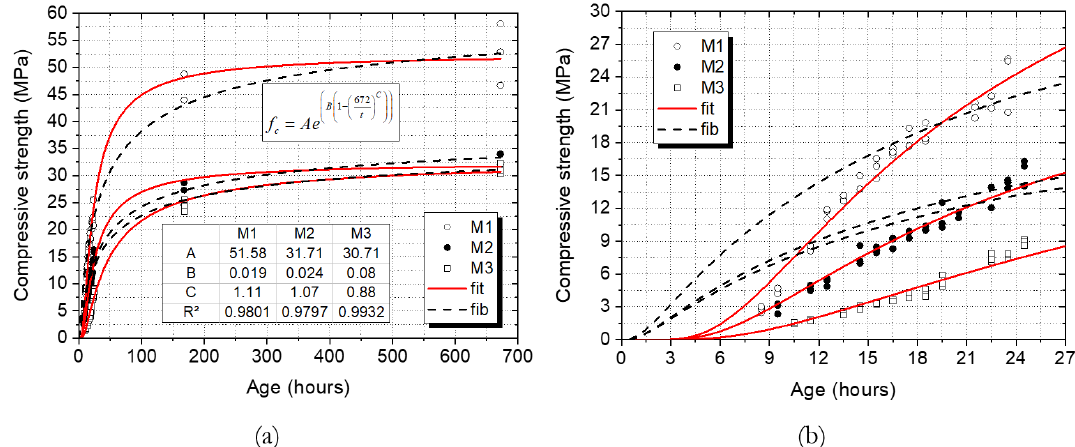
Figure 3 – Variation in the compressive strength over time: (a) during 28 days and (b) during 24